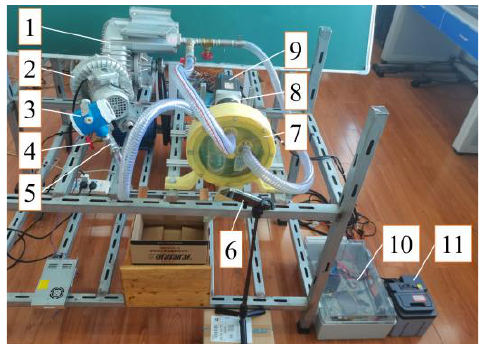
Figure 11. Platform of seed-metering device performance test. (1) Fan I, (2) fan II, (3) digital pressure gauge, (4) regulating valve, (5) tee joint, (6) iPhone camera, (7) inside-filling pneumatic seed-metering device, (8) planetary gear retarder, (9) DC motor, (10) control system, and (11) lithium battery.